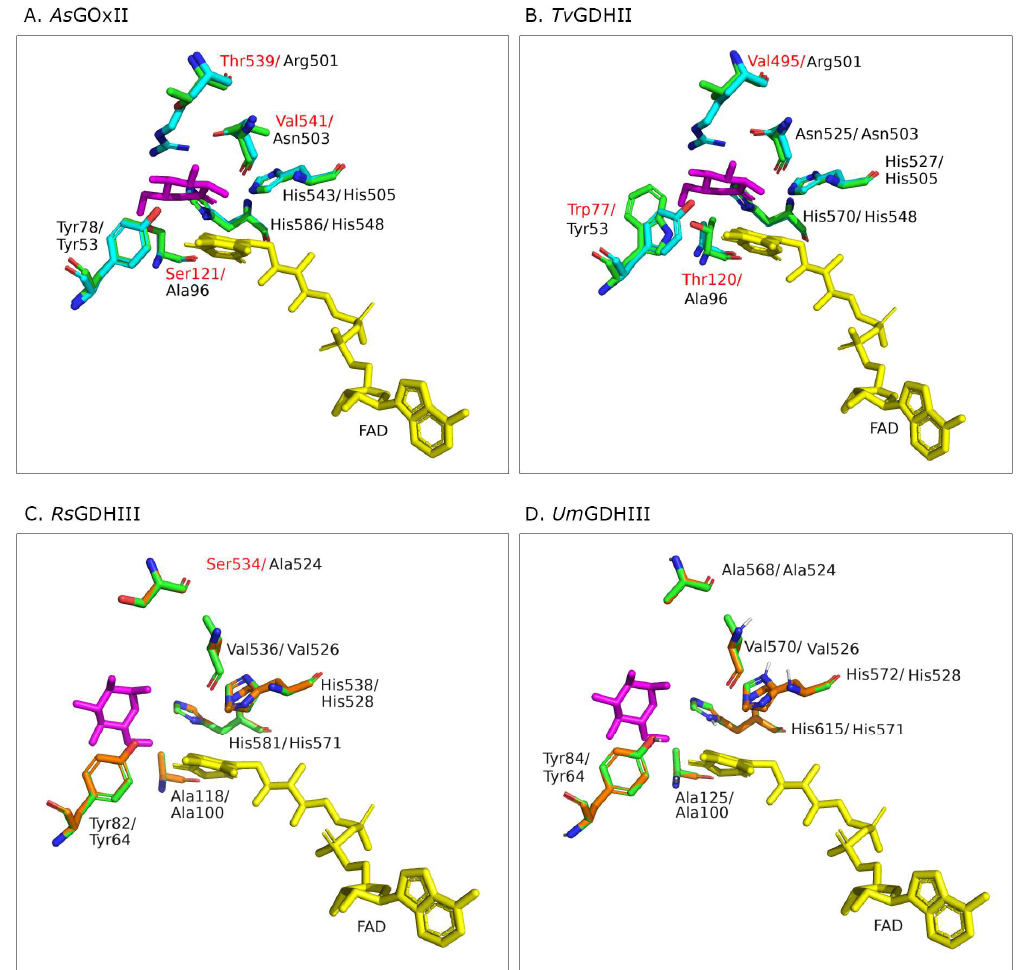
Figure 4. Superimposition of the structural models of AA3_2 glucose oxidoreductases ( green ) and the best model templates: As GOxII and Tv GDHII were superimposed to Af GDH (4YNU; cyan ) based on the six residues responsible for glucose binding [8], while Rs GDHIII and Um GDHIII were superimposed to Pc GDHIII (6XUU; orange ) [6]. Non-conserved active site residues in the respective AA3_2 glucose oxidoreductases are indicated in red. Glucose is shown in magenta.